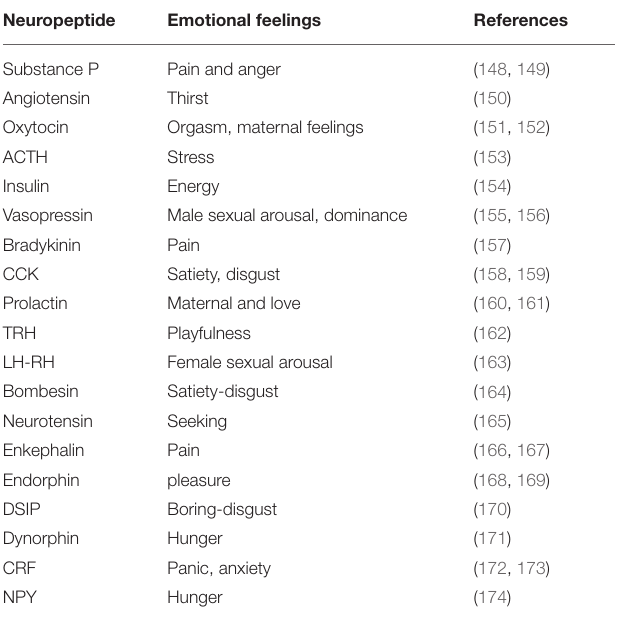
TABLE 3 | Monoamine and chemicals for